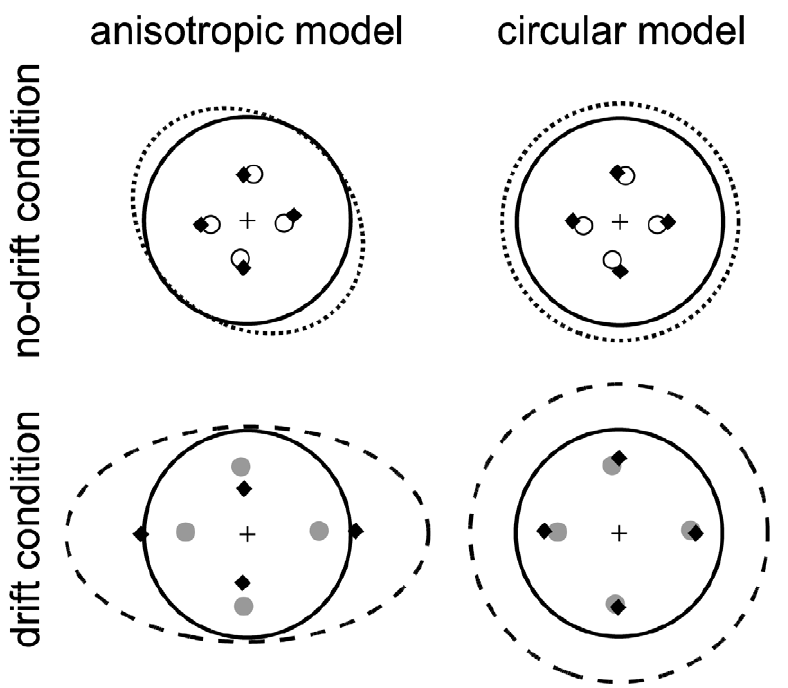
Figure 4. Ideal and observed aimpoints. Observed aimpoints (circles) are plotted along with MEG-predicted aimpoints (diamonds) for subject S4. Left column: MEG predictions based on the estimated covariance of endpoints in each condition. Right column: MEG predictions based on the fit of an isotropic Gaussian to the zero-penalty data. Dotted and dashed curves are identical to those in Fig. 2.